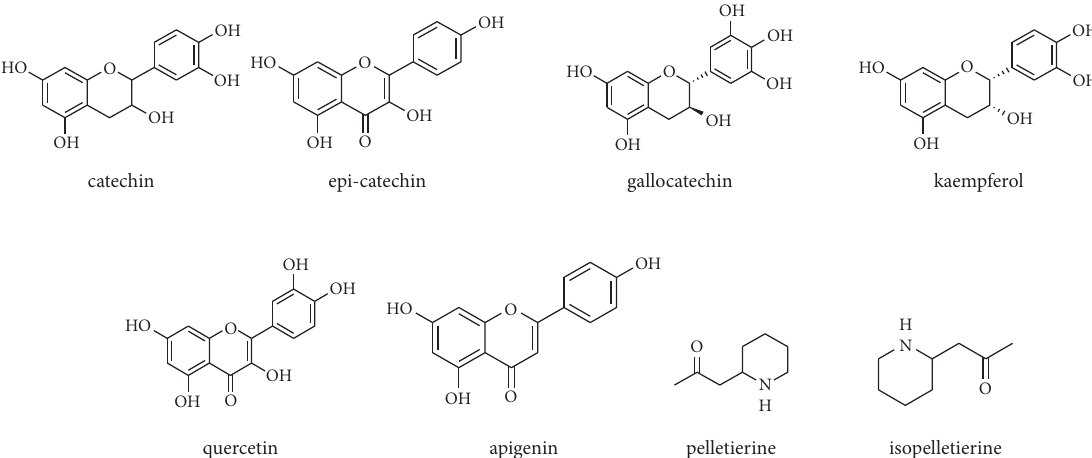
Figure 3: The main flavonoid and alkaloid compounds in pomegranate.